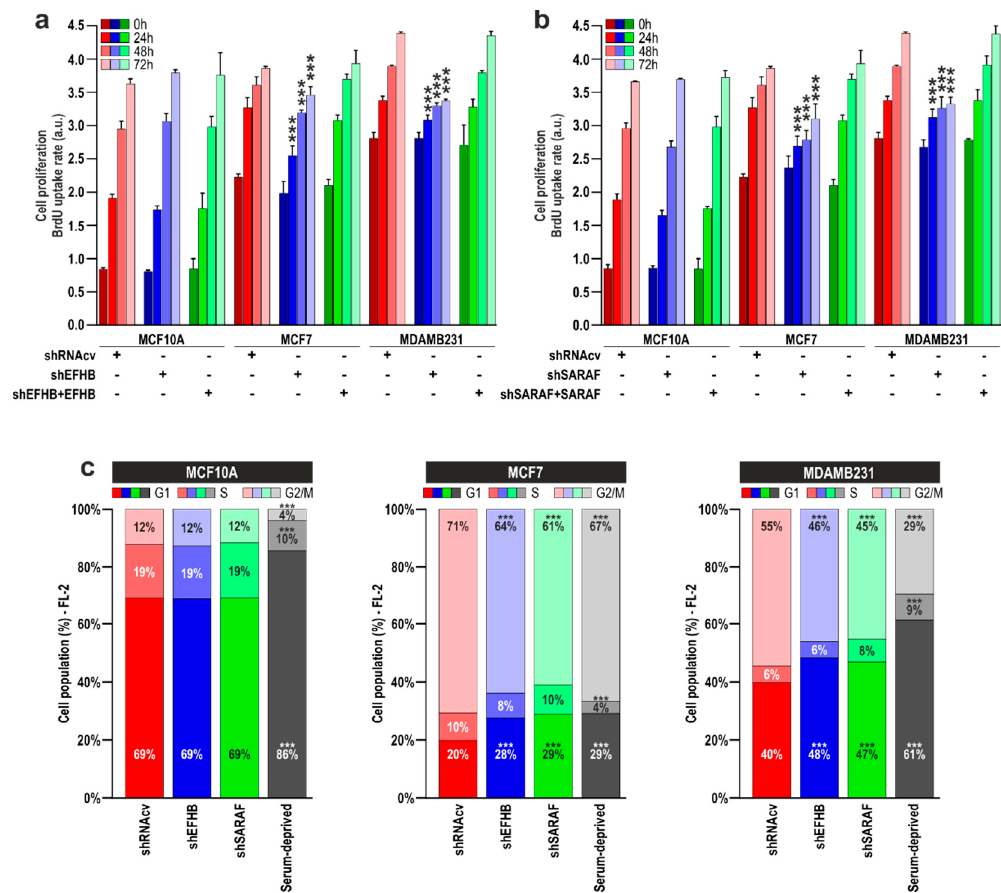
Figure 4. EFHB and SARAF are required for cell proliferation in breast cancer and pre-neoplastic epithelial cells. ( a , b ) MCF10A, MCF7, and MDA-MB-231 cells were transfected with shEFHB alone or in combination with EFHB expression plasmid ( a ) shSARAF alone or in combination with SARAF expression plasmid; ( b ) or scramble plasmids (shRNAcv as control), as indicated. Forty-eight hours after transfection, cell proliferation was assessed using the BrdU cell proliferation assay kit, as described in Material and Methods, for a further 24, 48, and 72 h. Bar graphs represent cell proliferation 0, 24, 48, and 72 h after the beginning of the experiment, presented as BrdU uptake rate. *** p < 0.001 compared to the corre- sponding control (cells transfected with shRNAcv). ( c ) MCF10A, MCF7, and MDA-MB-231 cells were transfected with shEFHB, shSARAF, or scramble plasmids (shRNAcv as control), or were serum-deprived, as indicated. Forty-eight hours later, cell cycle analysis through PI staining and following flow cytometry was performed, as described in “Materials and Methods”. Stacked bars are representative of six independent experiments.